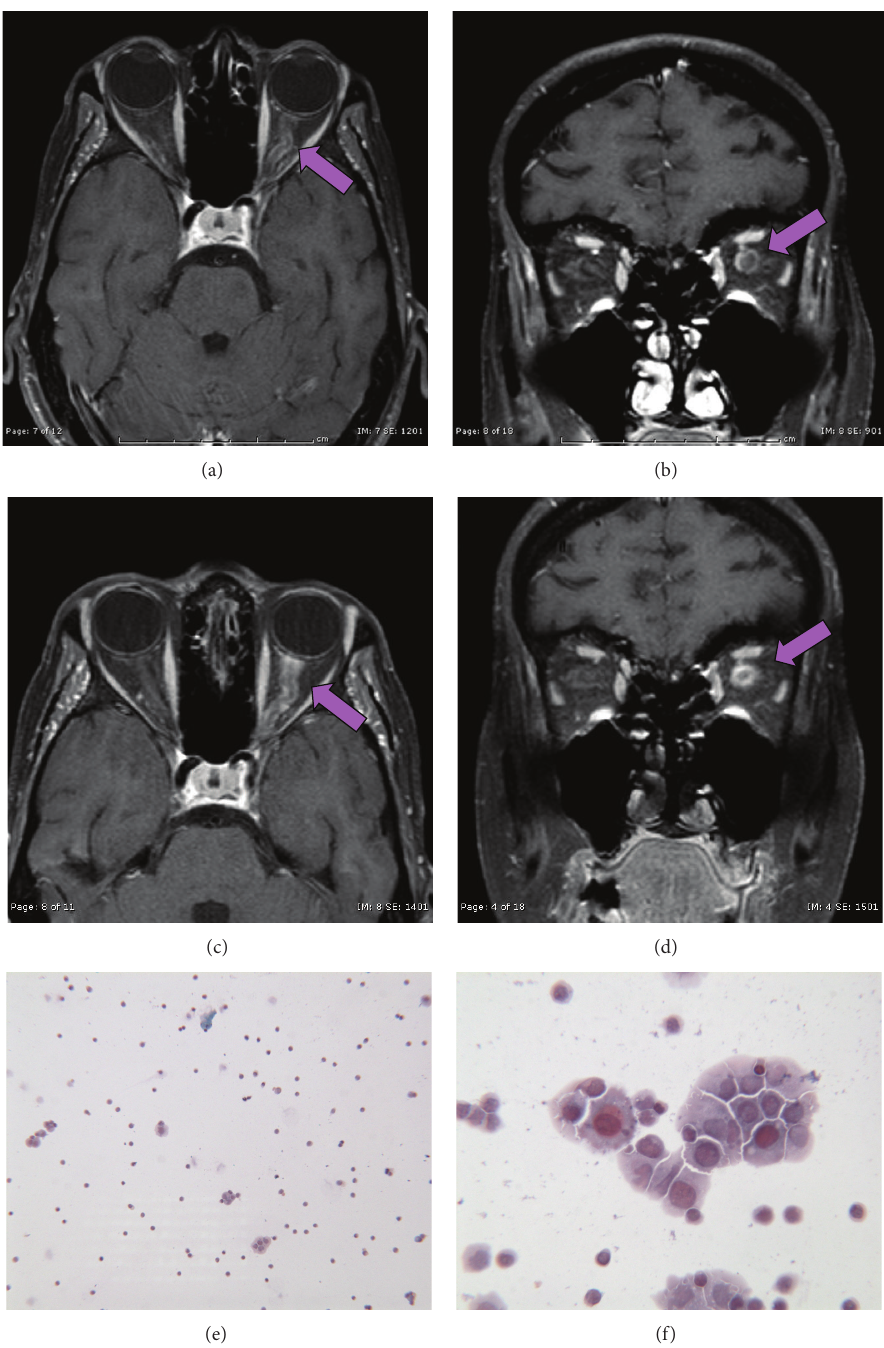
Figure1:((a)–(d))Contrast-enhancedcerebralMRIshowingdiffuseenhancementoftheleftopticnerveatonset((a),axialT1;(b),coronalT1) and at 2 months followup ((c), axial T1 SE FSAT; (d) coronal T1 SE FSAT). ((e)-(f)) Cerebrospinal fluid cytology showing atypical epithelial cells